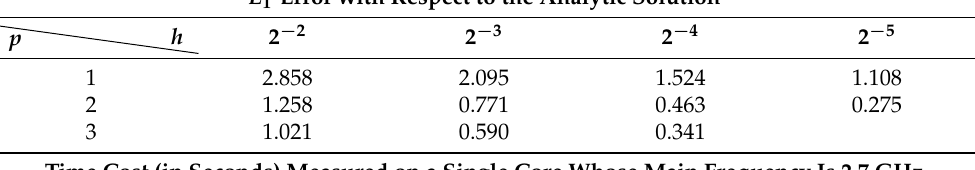
Table 1. Accuracy and time cost of each solver–mesh ( p – h ) pair. L 1 -Error with Respect to the Analytic